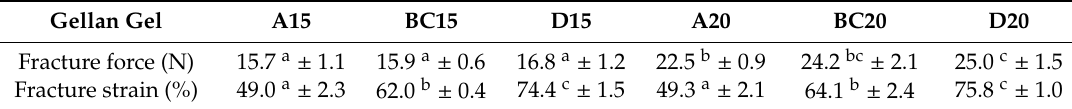
Table 2. Fracture properties of gellan gels used as soft food models.